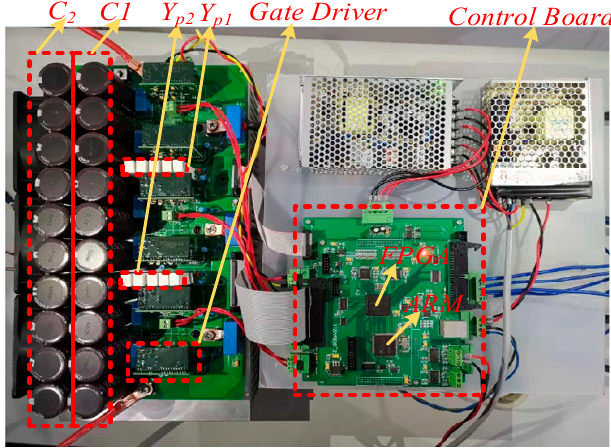
Figure 14. The module of an NPC Converter.